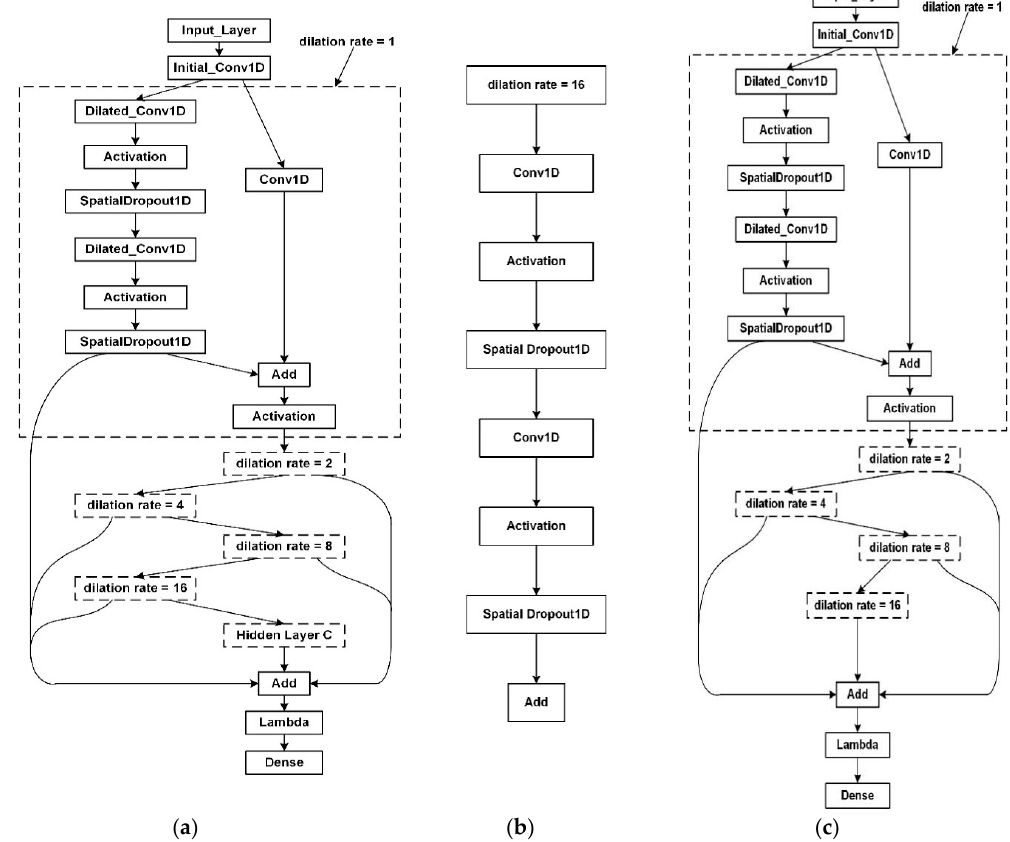
Figure 9. The TCN structure proposed in this paper and the initial TCN structure proposed in [19]. ( a ) shows the TCN structure used in this paper; hidden layer C is added to the TCN structure. ( b ) is the structure of hidden layer C. ( c ) is the initial TCN structure proposed in [19].